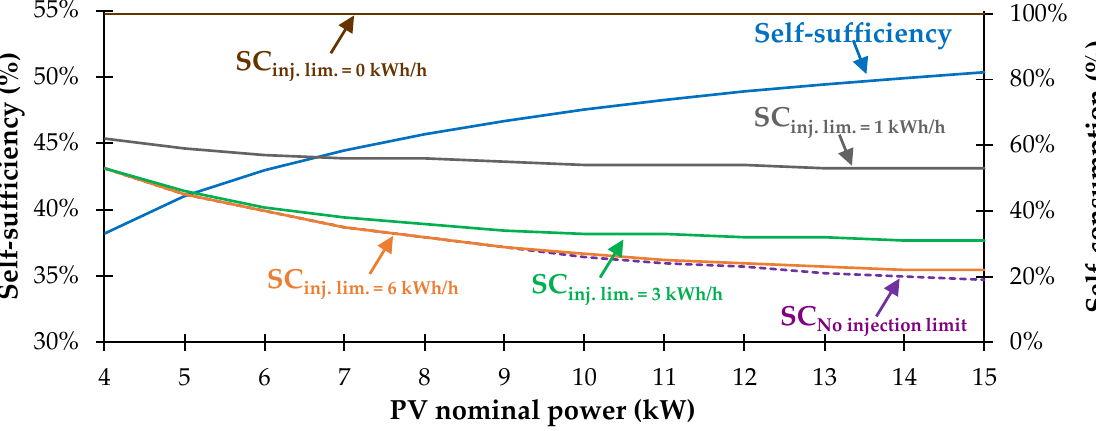
Figure 10. SC and SS as functions of PV nominal power with different injection limits.